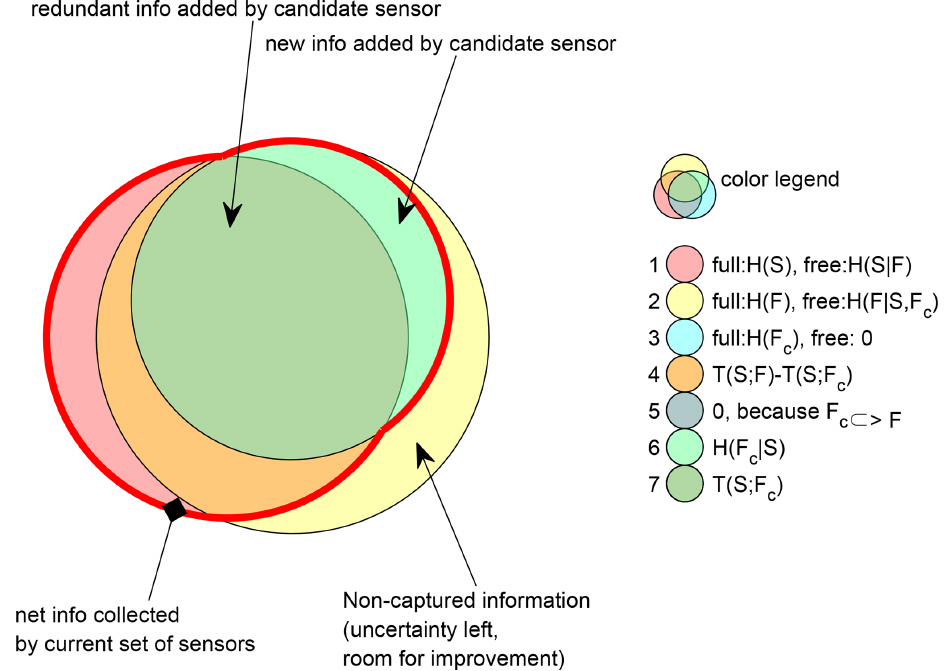
Figure 1. Venn diagram illustrating the relations between the relevant information measures. In the legend, the joint and marginal information-theoretical quantities (joint) entropy H(X) , conditional entropy H(X | Y) , and transinformation T (X ; Y) for the variable from sets of already selected sensors S , not yet selected sensors F , and the current candidate sensor F C are represented by the surfaces in the Venn diagram. For the three basic circle colors (first three circles in the legend), “free” gives the quantity represented by the non-covered part, and “full” gives the quantity represented by the entire circle surface. The joint entropy that is proposed to be maximized in this paper is the area enclosed in the thick red line. Table 1. Various information-theoretical objectives used by methods proposed in recent